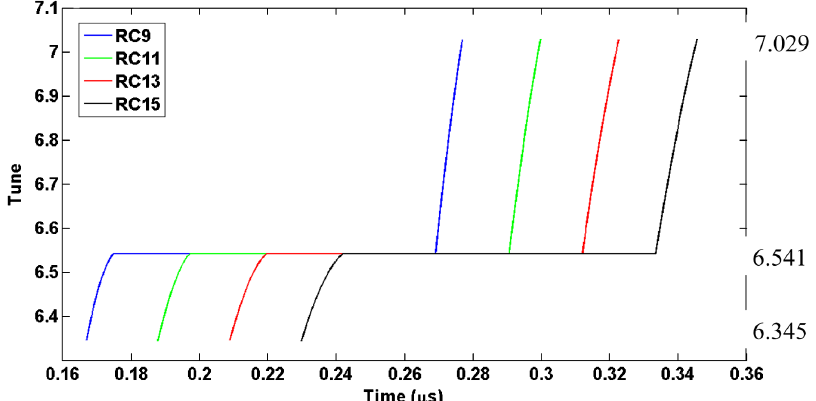
FIG. 5. Analytical tune profile (including coherent contribution) calculated on the first turn for the 21 mA beam, at RC9, RC11, RC13, and